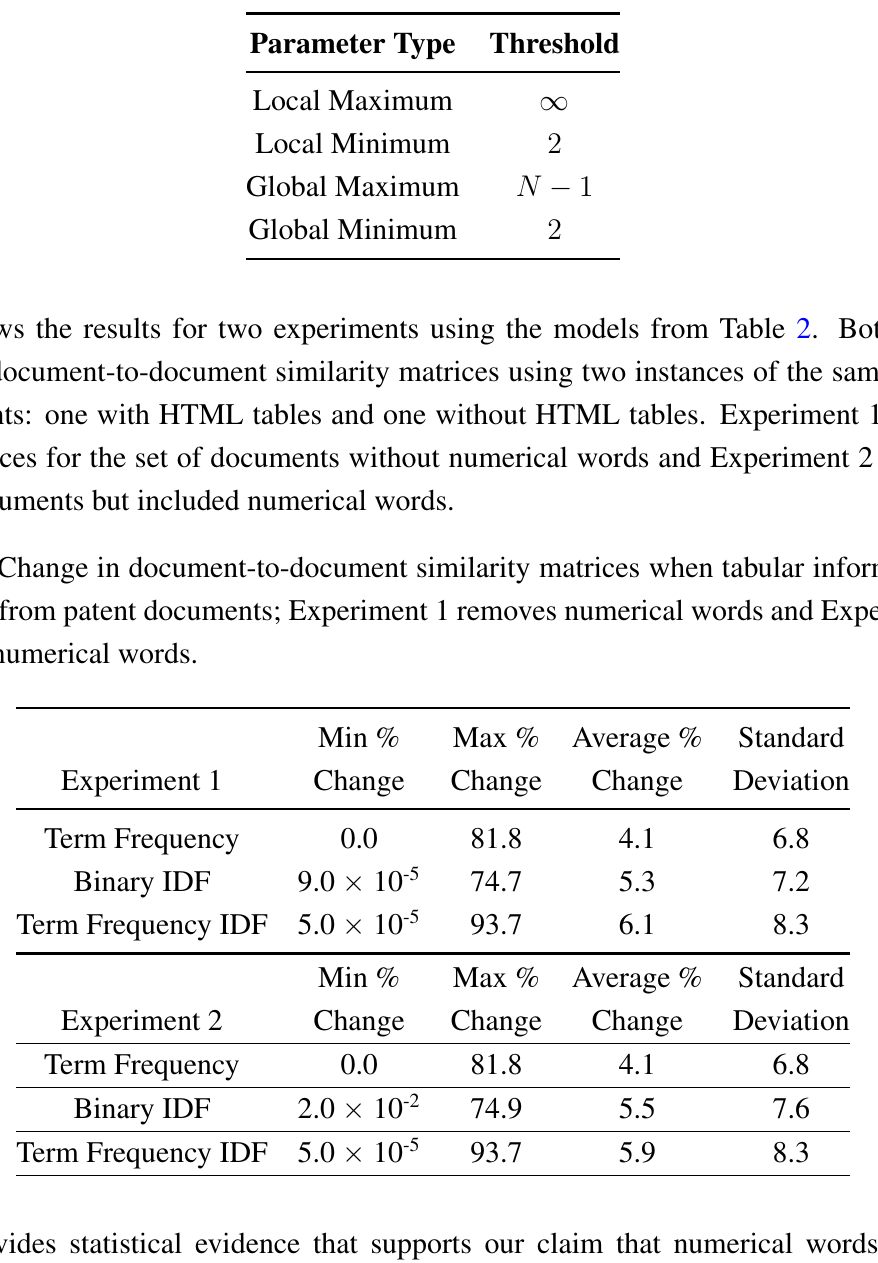
Table 4. The parameters selected and implemented for the main experiments; N is the total number of patent documents parsed.